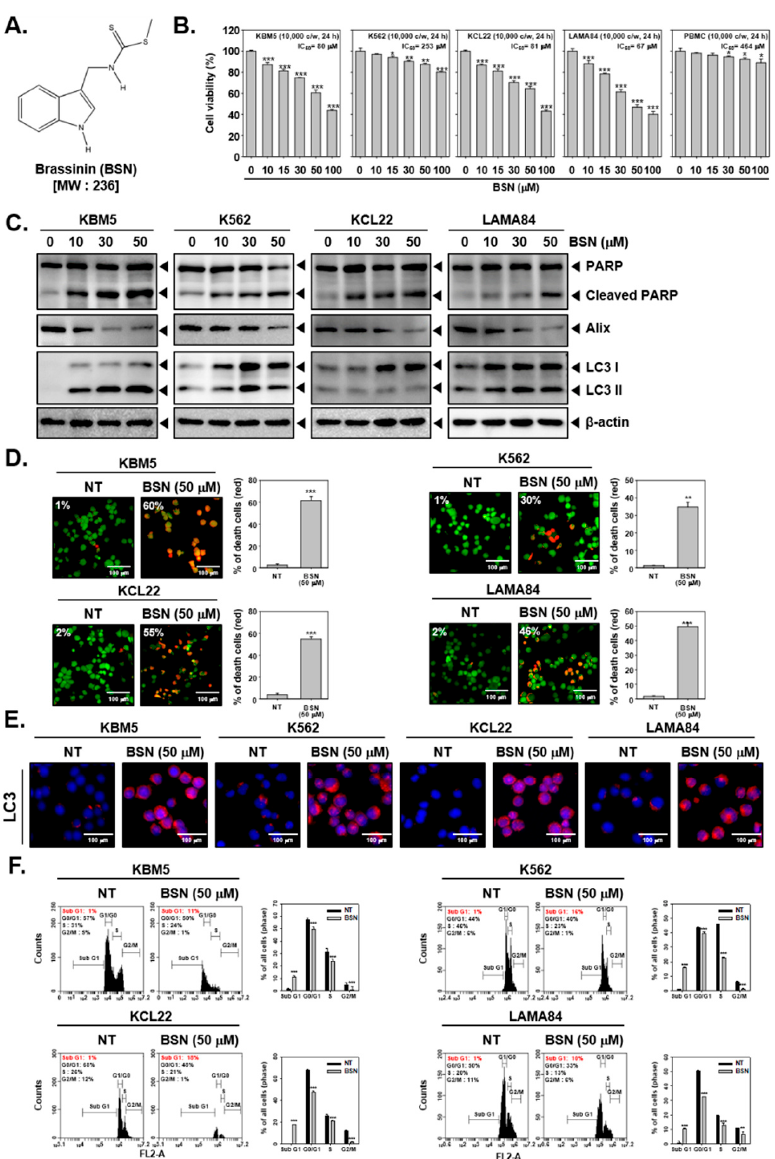
Figure 1. BSN induces cell death. ( A ) The chemical structure of Brassinin (BSN). ( B ) KBM5, K562, KCL22, and LAMA84 cells were treated with BSN (0, 10, 15, 30, 50, 100 µ M) for 24 h and MTT assay was performed. * p < 0.05 vs. non-treated (NT) cells, ** p < 0.01 vs. non-treated (NT) cells, and *** p < 0.001 vs. non-treated (NT) cells. ( C ) The cells were treated with BSN as described above panel B, and immunoblotting was conducted. ( D ) The cells were treated with BSN (50 µ M) for 24 h and live and dead assay was conducted. ( E ) The cells were treated as described above in panel D; expression of LC3 was elaborated with immunocytochemistry. ( F ) The cells were treated as described above in panel D; apoptotic cells were analyzed via cell cycle analysis. Data represent mean ± SD. *** p < 0.001 vs. non-treated (NT) cells. The results shown are representative of the three independent